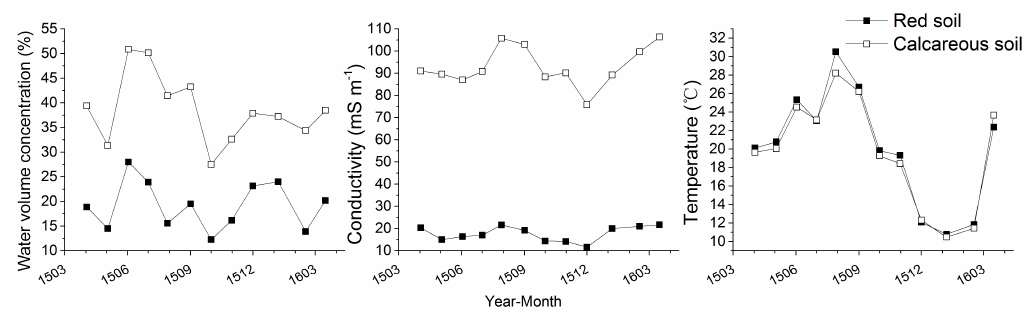
Figure 2. Temperature, water volume concentration and conductivity in the calcareous and red soils.